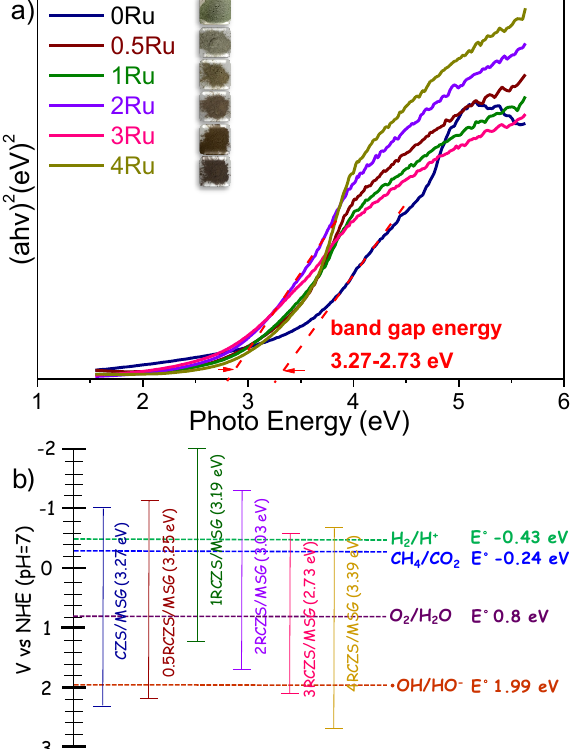
Figure 3. ( a ) UV-Vis absorption spectra of ruthenium-modified CZS / MSG heterostructured photocatalysts. Inset displays the digital camera photos for the corresponding productions. ( b ) Energy-level diagram revealing the conduction band (CB) and valence band (VB) edge positions of ruthenium-doped CZS / MSG heterostructured photocatalysts.